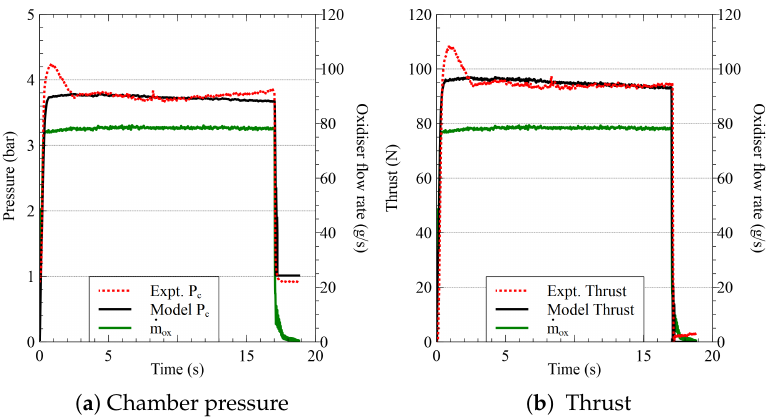
Figure 11. Comparison between experimental and numerical simulation results at a lower oxidizer mass flow